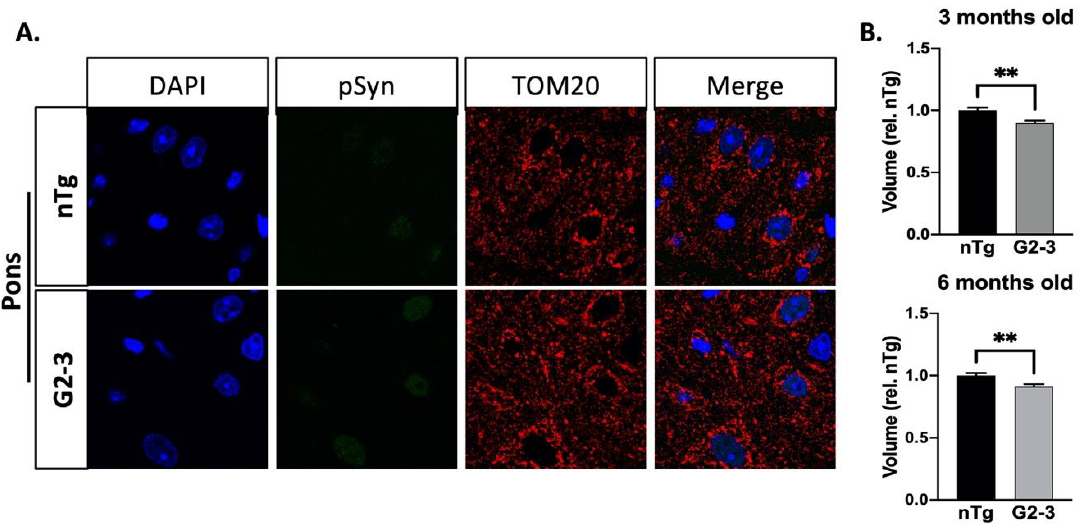
Figure 6. No mitochondrial enlargement is found in the pons of presymptomatic mice. ( A ) Representative confocal images of pSyn and mitochondria (TOM20) in three-month-old control and TgA53TG2-3 mice. Scale bar: 10 µm. ( B ) Quantification of mean mitochondrial and neuronal somas of 3- and 6-month-old mice shows mildly decreased mitochondrial volume by about 10% (3m.o.: p = 0.001; 6m.o.: p = 0.0019). SEM are displayed (SEM/SD: 3m.o.: nTg = 0.02267/0.7828, G2-3 = 0.02134/0.7483; 6m.o.: nTg = 0.02198/0.7703, G2-3 = 0.01825/0.6907), based on unpaired t -tests with Welch’s correc- tion. ( n = 3 per genotype). (** p ≤